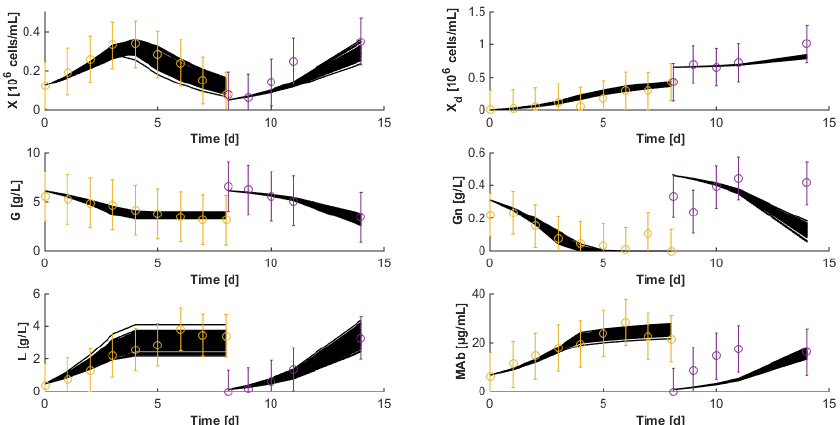
Figure 9. Monte-Carlo analysis of the cross validation of the HB1 model: the solid lines represent 100 model trajectories corresponding to normally distributed parameters characterized by the standard deviations of Table 3. Circles represent the experimental measurements with a confidence interval of